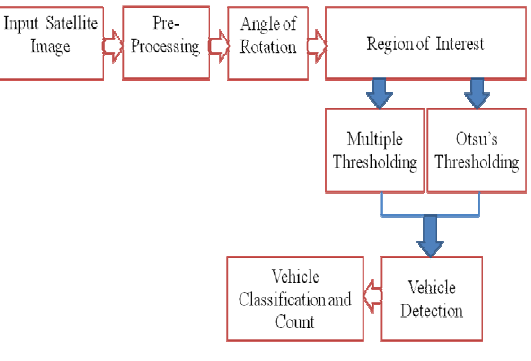
Figure 5: Overall Flow of the System 2.1 Pre-processing the Input